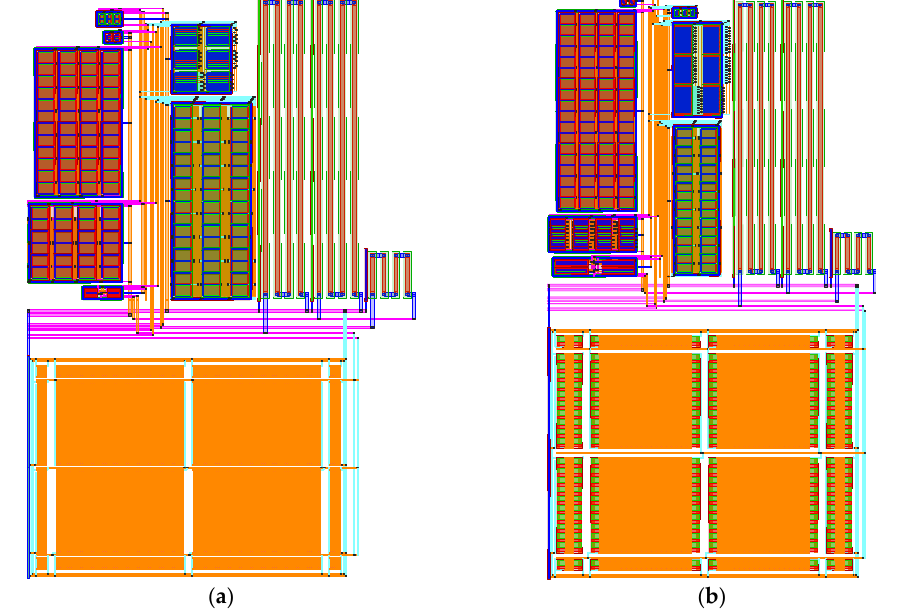
Figure 11. Generated layout examples of the HPF in a 22 nm technology based on the placement pattern given in Section 4.3 (vector graphic exports from the actual layouts, thus slight deviations might occur). While ( a ) includes the amplifier variant “LP”, ( b ) instantiates the amplifier variant “Speed”. In order to get a rectangular shape, the capacitor arrangement at the bottom was generated with adapted unit device sizing.